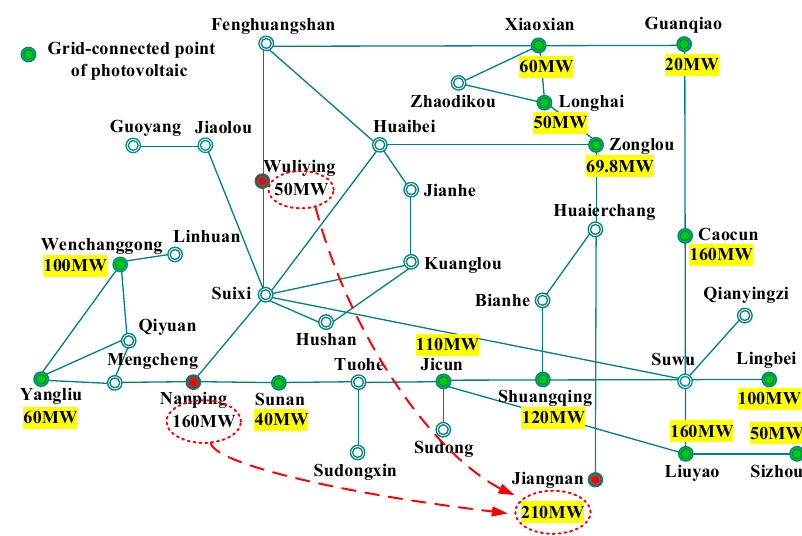
Figure 19. A modified scheme of the connection of photovoltaic power stations in Huaisu power grid.